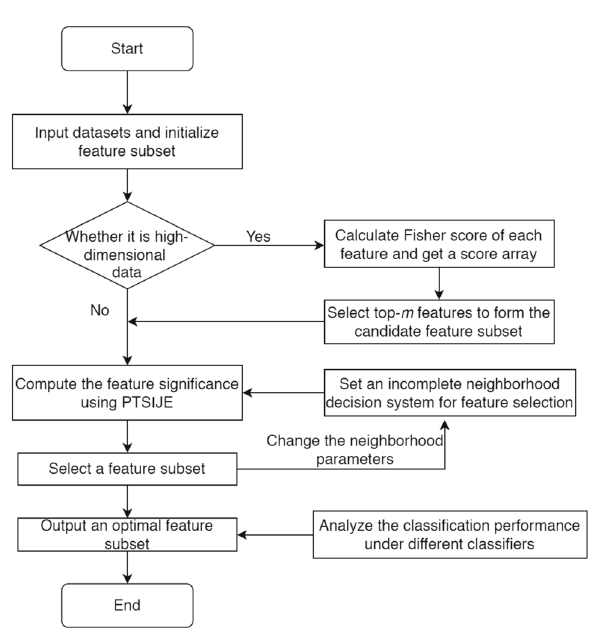
Fig. 1 Process flow of the feature selection method for data classifica- tion